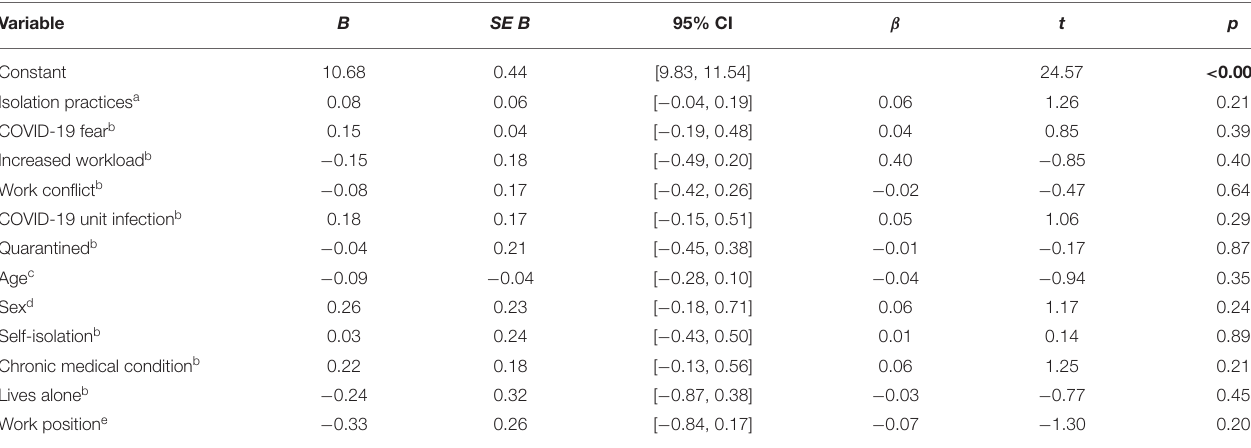
TABLE 7 | Multiple linear regression analysis for worker variables predicting PROMIS sleep disturbance score. Variable